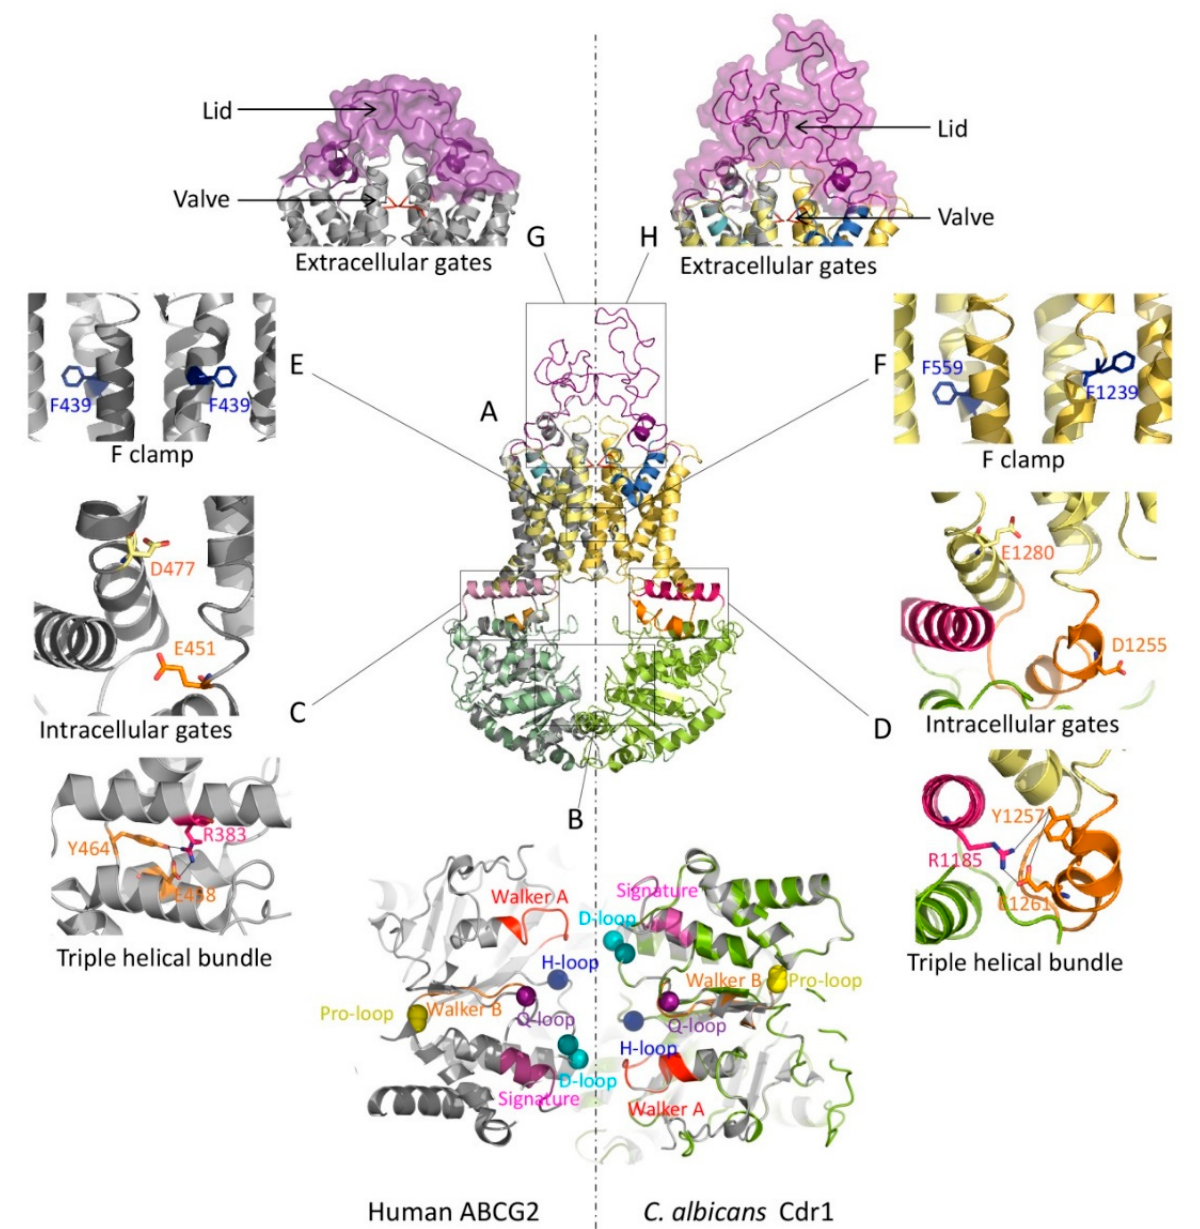
Figure 3. Type II mammalian and fungal ABCG/PDR exporters share functional domains. ( A ) A homology model of the PDR exporter Cdr1 from C. albicans was generated using the SWISS-MODEL tool (color ribbon, NBD: green, TMD: yellow, elbow helix: pink, ICL: orange, valve: red, re-entry helix: blue and ECL: purple). The Cdr1 model was superimposed with the cryo-EM structure of human ABCG2 (PDB ID: 6VXF) (gray ribbon). ( B ) Zoom-in top view of the NBD dimer from panel A at the NBD–NBD interface shows essential conserved motifs (Walker A: red, Q-loop: violet, signature: pink, Pro-loop: yellow, Walker B: orange, D-loop: cyan and H-loop: blue). The transmission interfaces of human ABCG2 ( C ) and C. albicans Cdr1 ( D ) show a network cluster of triple helical bundles (THB) with conserved tyrosine residues as part of a salt bridge between elbow helix and ICL. Two negative residues are shown as the intracellular gates. Conserved residues are shown as sticks with color-coding as in the topology model. The conserved phenylalanine F clamp F439 in human ABCG2 ( E ) and the putative F clamp in C. albicans Cdr1 ( F ) are indicated as sticks. At the extracellular gates, the valve-like structures at the top of central cavity (red) are shown at the corresponding position of human ABCG2 ( G ) and C. albicans Cdr1 ( H ). The lid-structure formed by ECLs is shown as a violet ribbon with a surface. The homo-dimeric human ABCG2 transporter has a symmetric lid ( G ), while the full-size C. albicans Cdr1 transporter has a larger ECL forming the outer lid and part of the roof architecture ( H ).